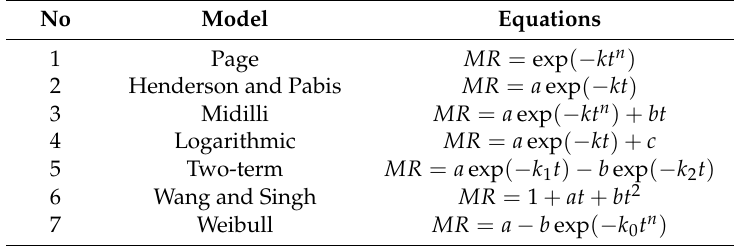
Table 1. Mathematical models used to predict the moisture ratios values